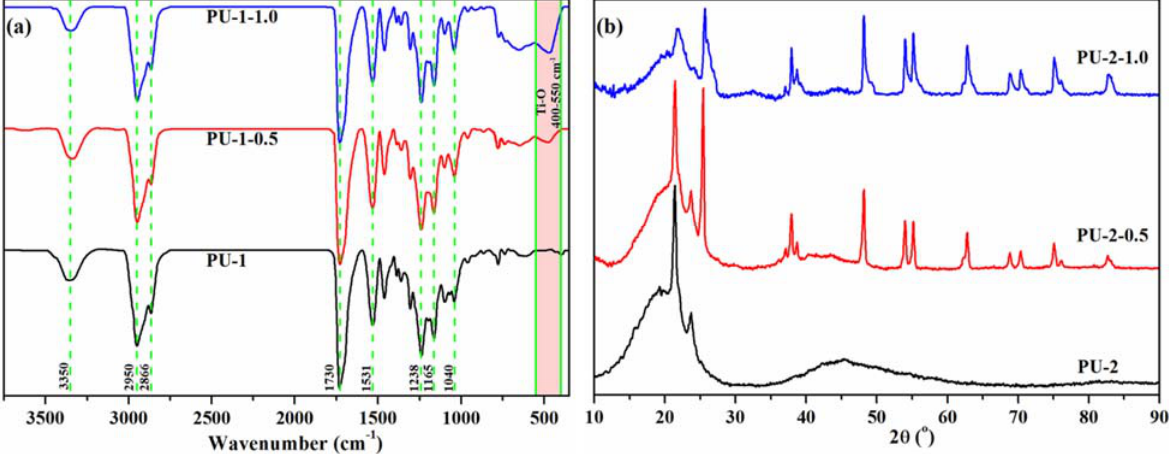
Figure 3. FTIR spectra of PU-1, PU-1-0.5 and PU-1-1.0 sample ( a ) and XRD patterns ( b ) for PU-2, PU-2-0.5 and PU-2-1.0 films.